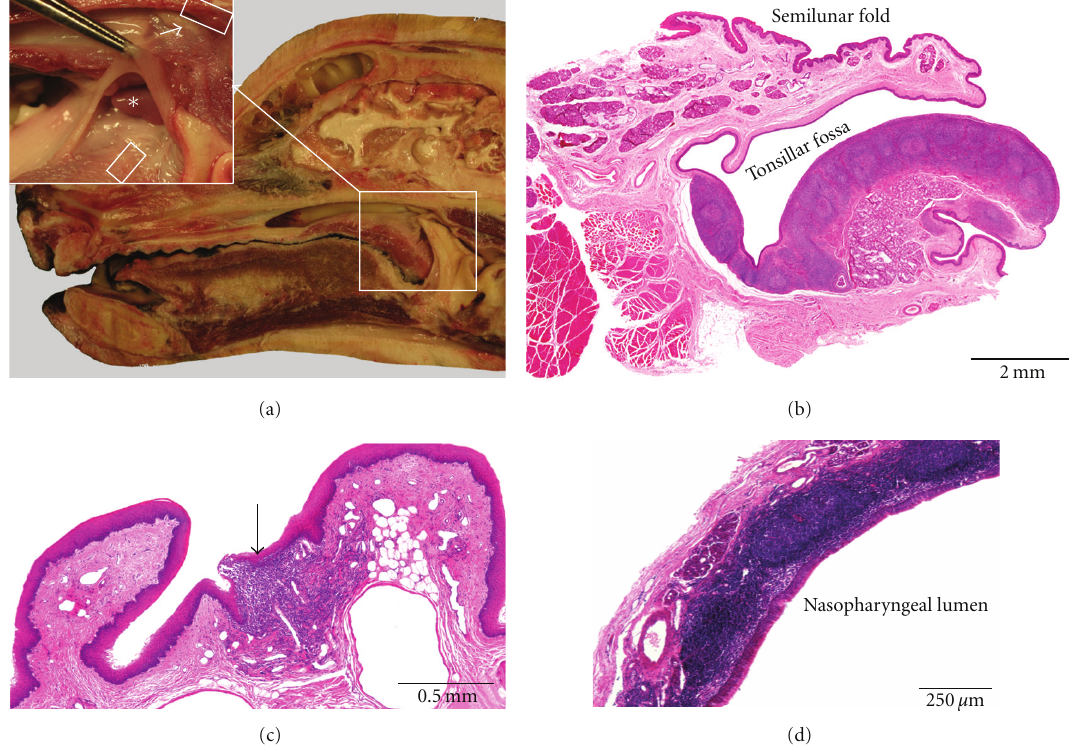
Figure 6: Anatomical localization and histological characteristics of the canine tonsils. (a) Median section through a canine head. The insert shows a higher magnification of the region in which the tonsils are located. In the dog, the lingual (lower boxed area of the insert), palatine (asterisk), and pharyngeal tonsils (upper boxed area of the insert caudodorsal to the opening of the auditory tube (arrow)) are present. (b) Histological section through the palatine tonsil that is partly covered by the semilunar fold. (c) Histological view of a part of the lingual tonsil that is composed of scattered aggregations of lymphoid cells (arrow). (d) Histological section through a part of the pharyngeal tonsil.